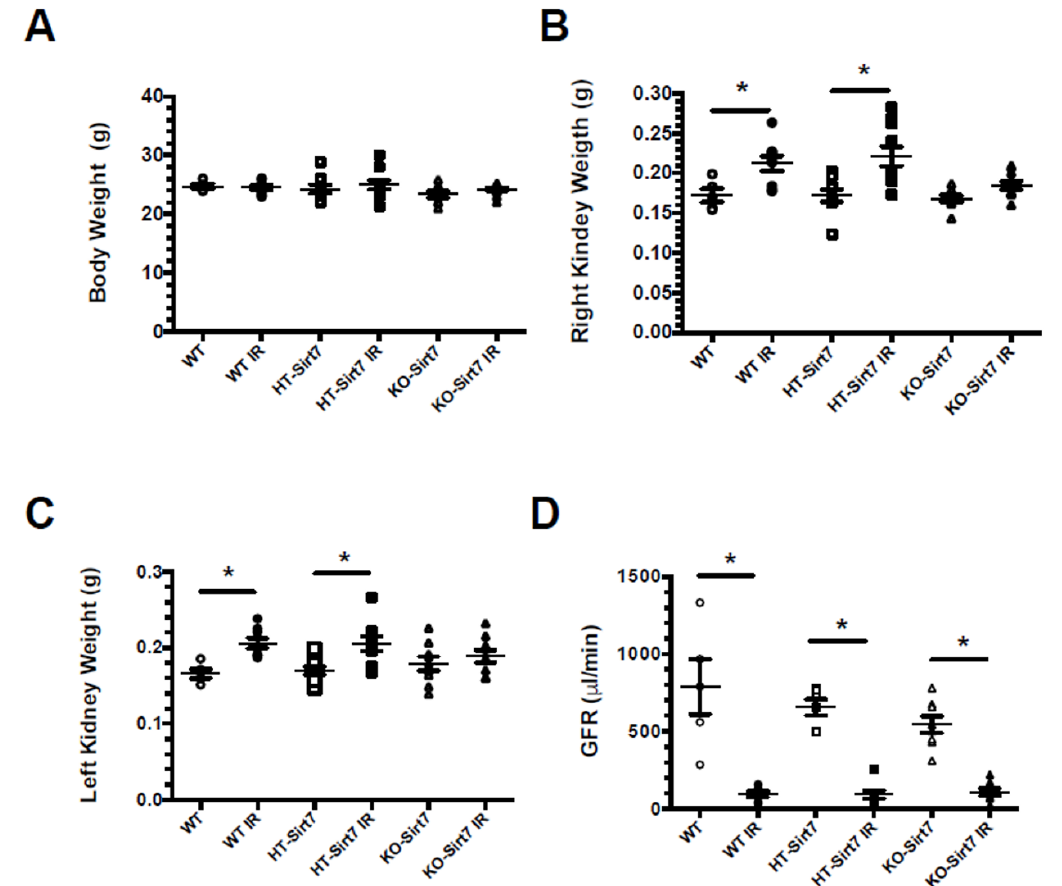
Figure 1. Effect of Sirt7 deficiency on the response to AKI. ( A ) Body weight, ( B ) Right kidney weight, ( C ) Left kidney weight, ( D ) Glomerular filtration rate. White circles represented WT, Black circles, WT+IR, White squares, HT-Sirt7, Black squares, HT-Sirt7+IR, White triangles, KO-Sirt7, and Black triangles, KO-Sirt7+IR. n = 5–10 per group. * p < 0.05 vs. the respective control group, as stated.